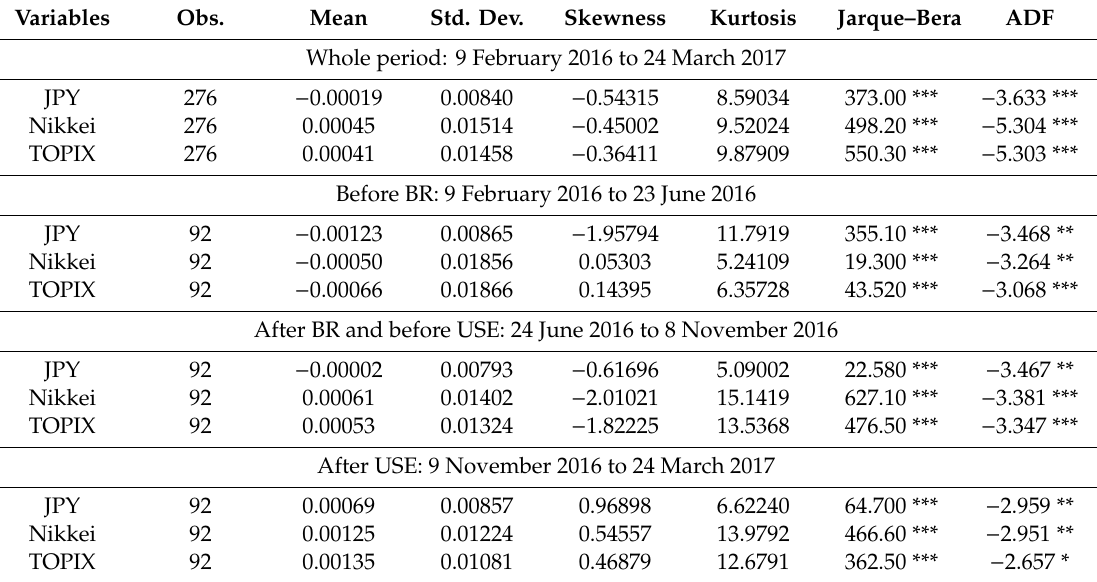
Table 1. Daily logarithmic returns of the exchange rates and stock price indexes. Variables